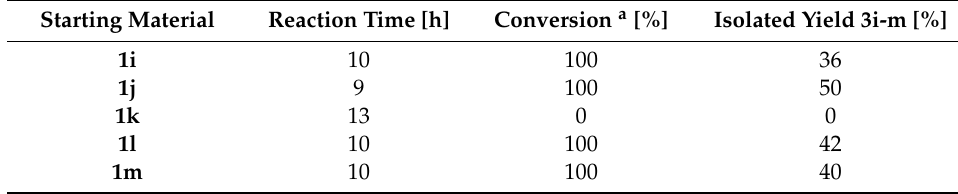
Table 3. Photocyclization of nitro-imines 1i-m .